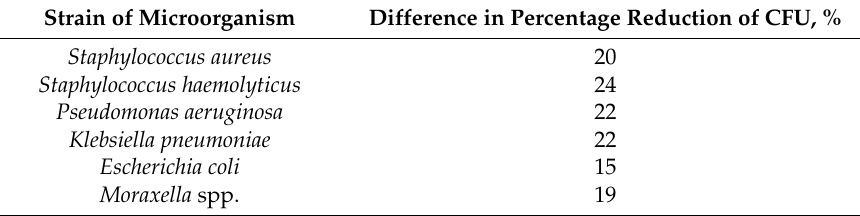
Table 7. Difference in percentage reduction of CFU between the groups of the AgNPs-containing bandage without laser irradiation and with laser irradiation four hours after inoculating the Petri dish and placing the